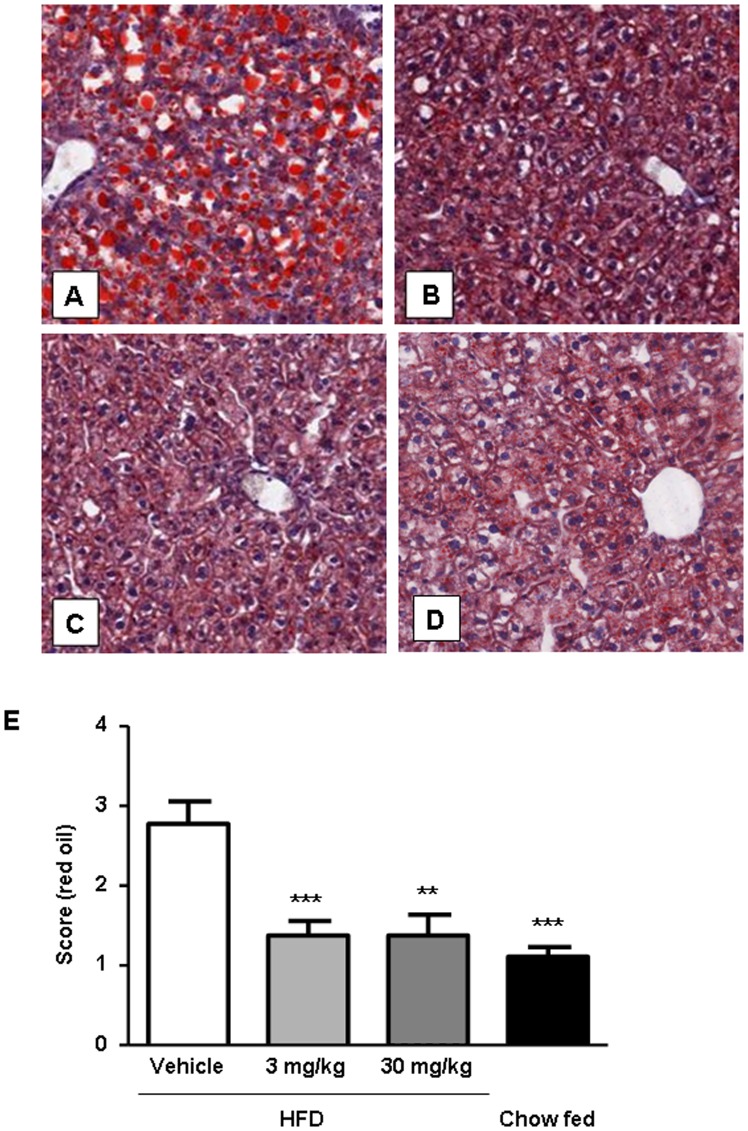
Evaluation of effect of linagliptin on hepatic steatosis.Oil Red O staining of liver specimens from diet-induced obesity (DIO) mice treated with vehicle (A), DIO mice treated with linagliptin 3 mg/kg/day (B), DIO mice treated with linagliptin 30 mg/kg/day (C) and chow-fed mice (D). Quantification of Oil Red O staining was performed by histologic scoring (n = 9 animals per group) (E). Data are shown as mean ± SEM. **P<0.01; ***P<0.001.